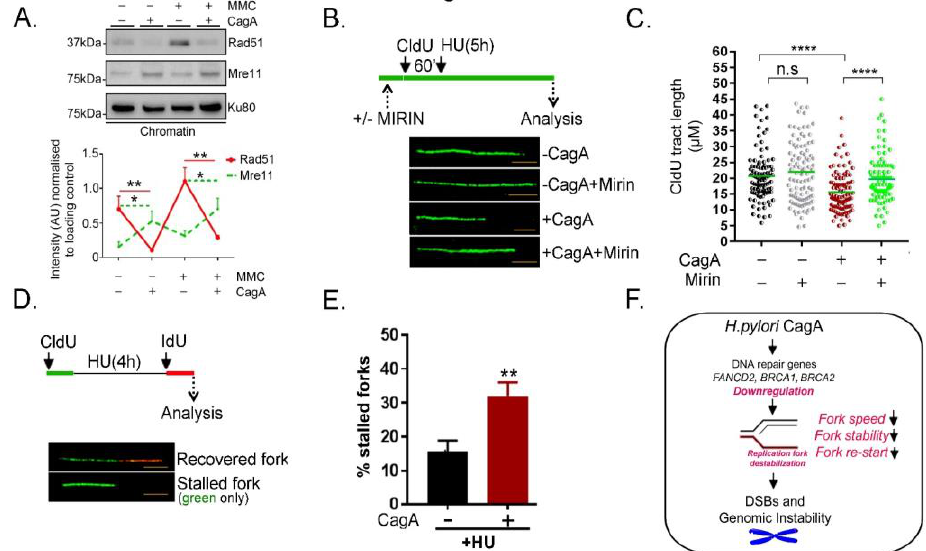
Figure 4. Poor Rad51 chromatin association in part contributes to compromised replication fork protection in CagA expressing cells ( A ). Dox inducible MKN28−CagA cells were either left untreated (−CagA) or subjected to doxycycline withdrawal (+CagA) for 48 h and left untreated or ex- posed to MMC (150 nM, 12 h). Immunoblot of chromatin fraction probed for Rad51 is shown. Right , quantification of the Western blot from three independent experiments were shown ( B,C ) Fork deg- radation in the presence or absence of Mirin - Fibre Assay Scheme: Cells were pre-treated with either DMSO alone or Mirin (50 M for 30 min). Pulse labelling was then done with CldU for 60 min, following which cells they were exposed to HU (4mM) for 5 h. Replication fork degradation was calculated by measuring the median CIdU tract length, as shown in (k) p = <0.0001 , n.s. — not signif- icant. At least 100 fibres were scored for each experiment. The experiment was repeated thrice yield- ing similar results. ( D,E ) Fork stalling-Fibre assay Scheme: Cells were exposed to CldU for 40 min followed by HU for 4 h. Cells were then labell ed with IdU for 60 min and “green - only” fibres were used to quantify percentage stalled forks. At least 100 fibres were scored for each experiment, n = 3. ( F ) Model explaining the defective replication fork recovery in CagA-expressing cells leading to genome instability. CagA expression results in downregulation of FANCD2, BRCA1, and BRCA2. As a consequence, the replication fork integrity in terms of replication speed, stability, and the abil- ity to recover from damage is impaired resulting in double strand breaks and genomic instability. Asterisks represent significant differences. * p < 0.05; ** p < 0.01; *** p < 0.001; **** p <0.0001. Therefore, we next asked whether inhibition or inactivation of hyper MRE11 activity can prevent nascent DNA degradation in CagA-expressing cells. Strikingly, prior incuba- tion with Mirin, an MRE11 specific small-molecule inhibitor, substantially rescued DNA fibre degradation and restored replication fork protection in CagA-expressing cells ( p < 0.0001) (Figure 4B,C and Figure S2D). The above data demonstrate that HR/FA downreg- ulation and the resultant impaired fork protection by Rad51 triggered heighten fork deg- radation in the presence of CagA. Lastly, we measured the percentage of stalled DNA replication forks by blocking on- going DNA replication with 4 mM HU for 5 h and we then measured the efficiency of DNA synthesis resumption. Here, CldU (green) was incorporated for 40 min, followed by a 2 mM HU treatment for 5h and subsequent IdU (red) incorporation for 60 min. Labelling of the second track (red) indicates efficient replication fork restart and green only tracts